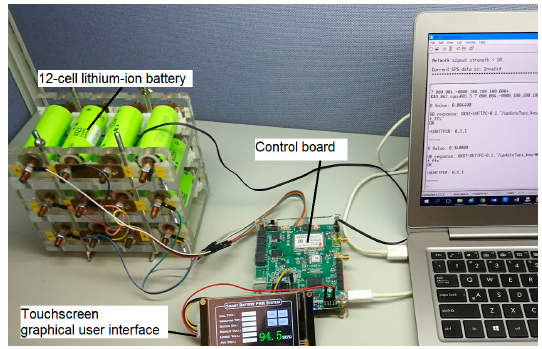
Figure 9. Test setup for 12-cell series Lithium-ion battery (LIB) and graphical-user-interface (GUI).